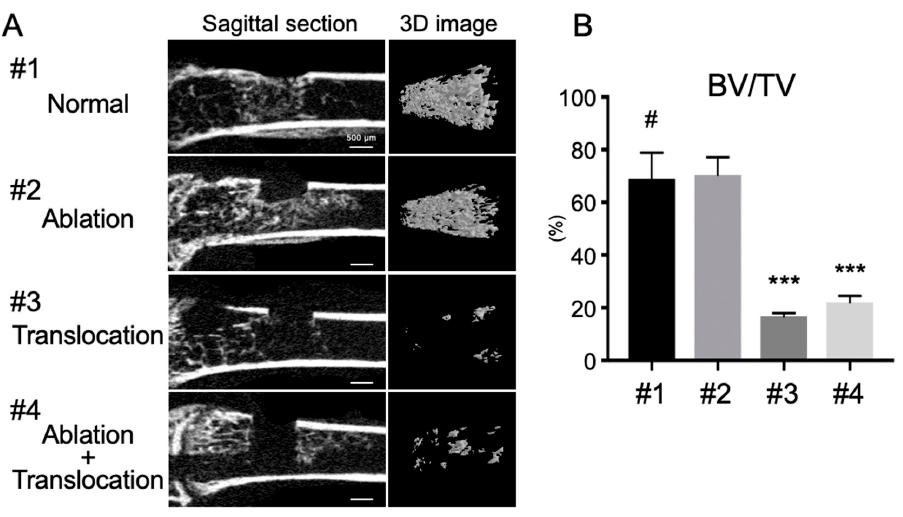
Figure 2. FGF-2, but not BMP-2, promotes repair of mouse femoral defect. Collagen pellets containing BMP-2 (10 μ g) or FGF-2 (1 μ g, 10 μ g) or DW (control) were transplanted into mouse femur